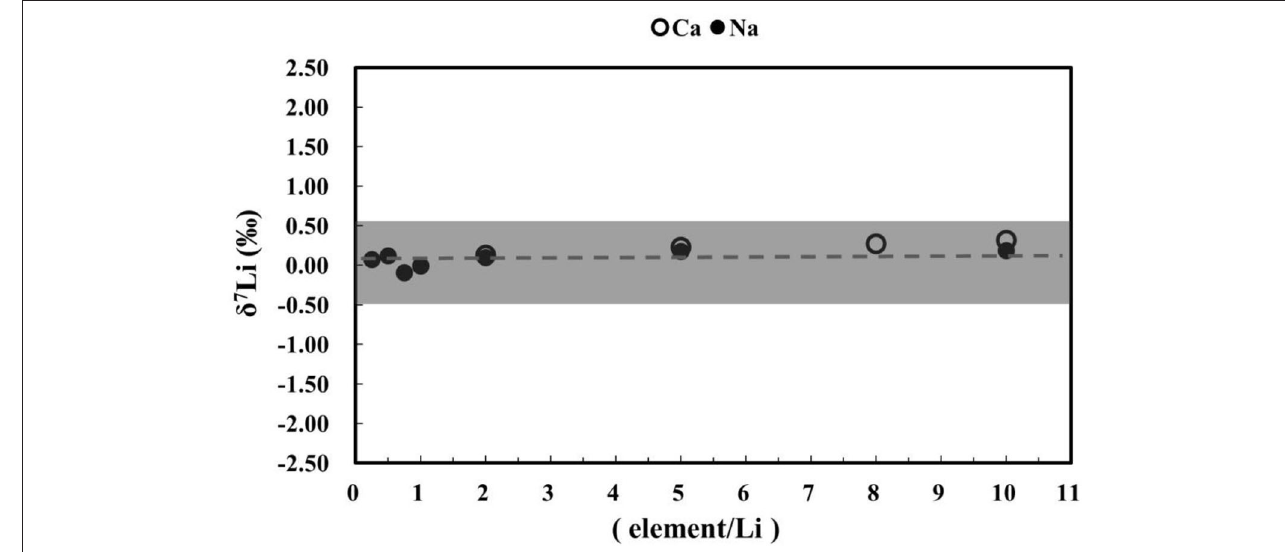
FIGURE 11 | Effects of Na and Ca on Li isotope measurements.